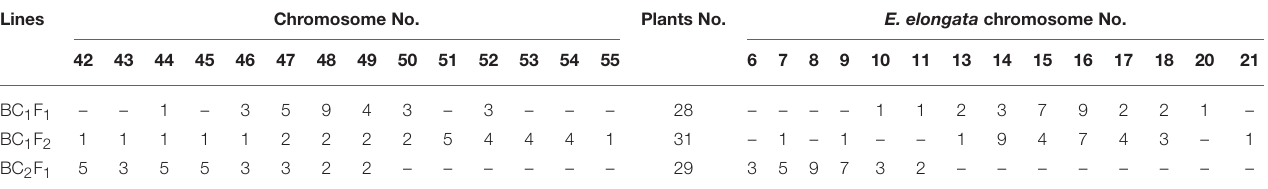
TABLE 3 | Chromosome segregation trends in wheat- E. elongata BC 1 F 1 , BC 1 F 2 , and BC 2 F 1 hybrids. Lines Chromosome No. Plants